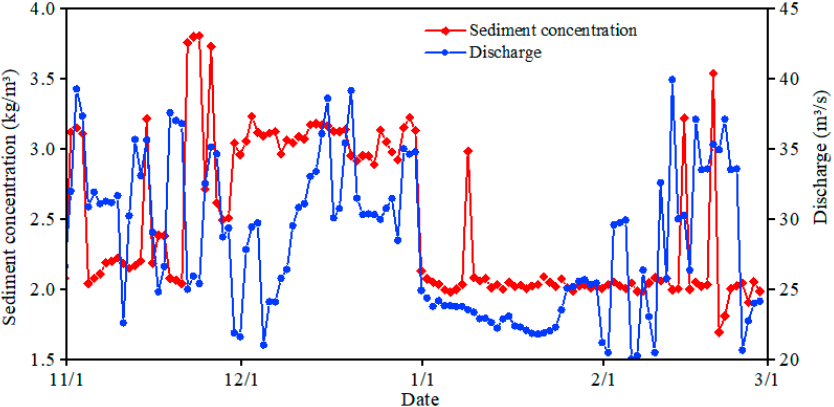
Figure 11. Flow and sediment concentration changes in non-flood season.